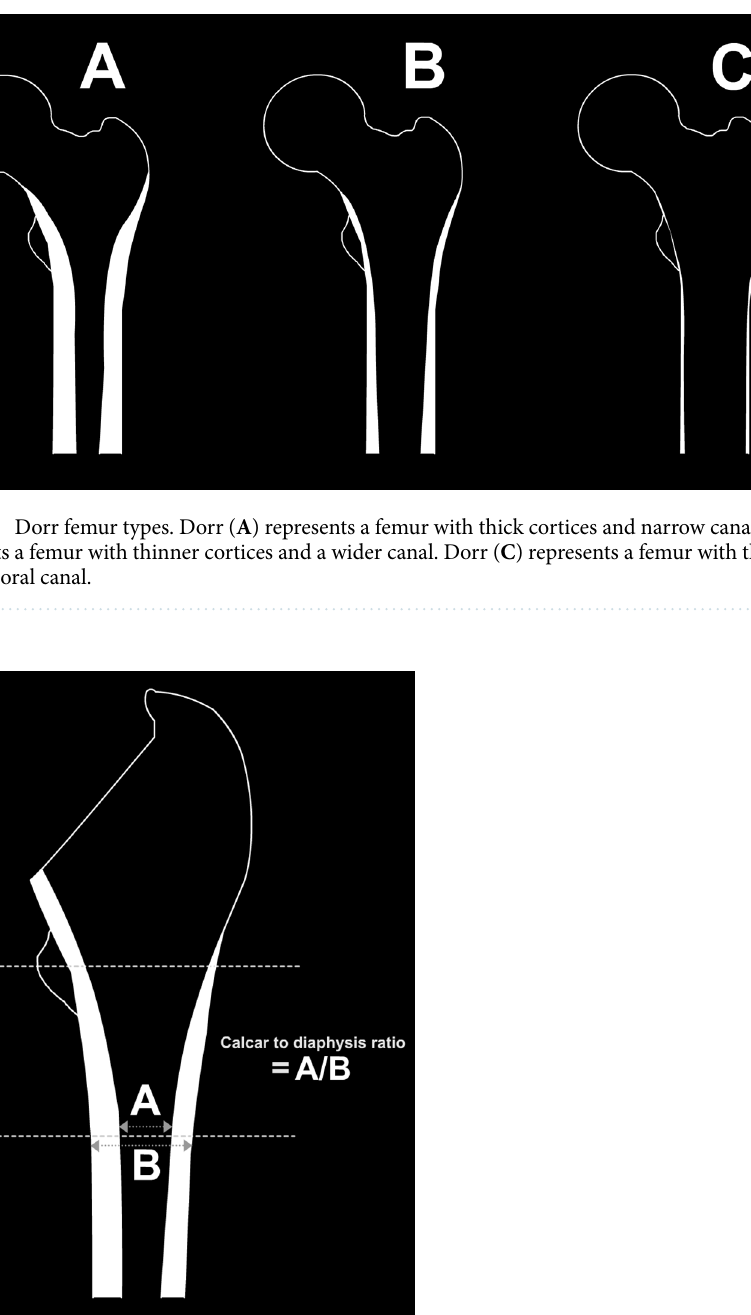
Figure 3. Canal to diaphysis ratio (CDR) is calculated by dividing the femoral canal width at a point 5 cm distal to the mid portion of the lesser (the black arrows) trochanter by the diaphysis width at the same point (the white